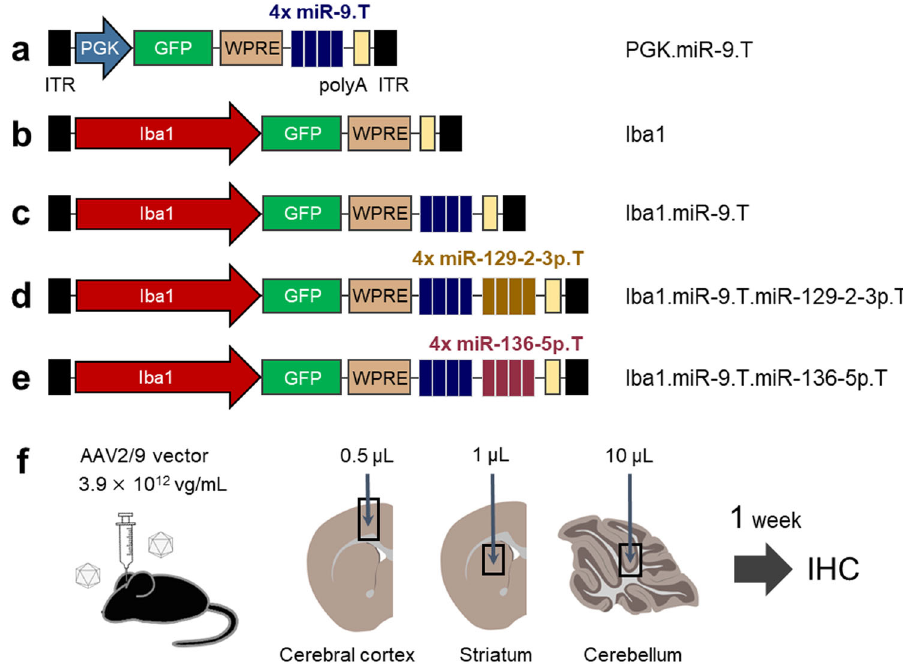
Fig. 1 Schema of AAV constructs and experimental procedure. a – e AAV vectors comprise the constitutive PGK promoter ( a ) or Iba1 promoter ( b – e ) followed by GFP, WPRE, and polyA. In addition, one or two sets of four repeated microRNA (miR) target sequences (4 × miR-9.T and 4 × miR-129-2-3p.T or 4 × miR-136-5p.T) were inserted between the WPRE and polyA sequences ( a , c – e ). Each construct was labeled with the abbreviated promoter name (PGK or Iba1) plus incorporated miR target(s) as described. f Mice received different doses of each AAV vector (3.9 × 10 12 vg/mL) to the cerebral cortex (0.5 μ L), striatum (1 μ L), and cerebellum (10 μ L). One week after the viral injection, the brains of the treated mice were examined by